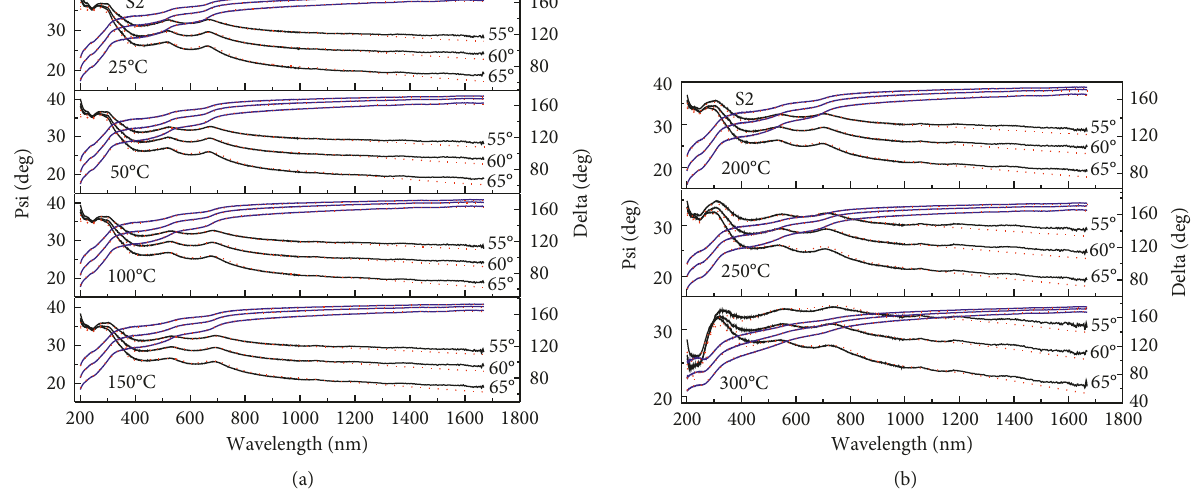
Figure 8: SE experimental data and model fitting for S2 at different